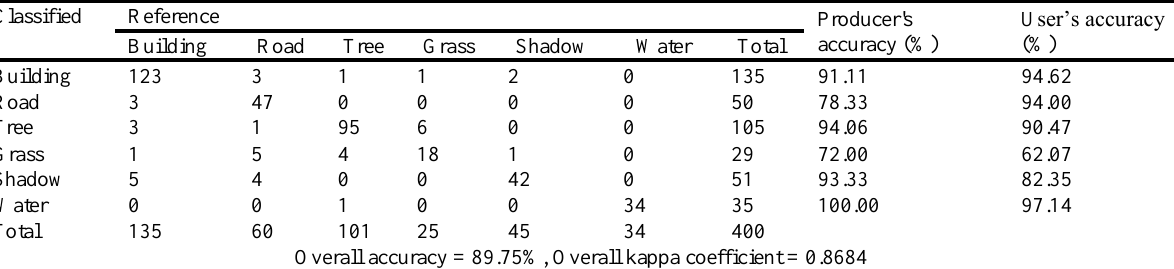
Table 9. Confusion matrix for Data